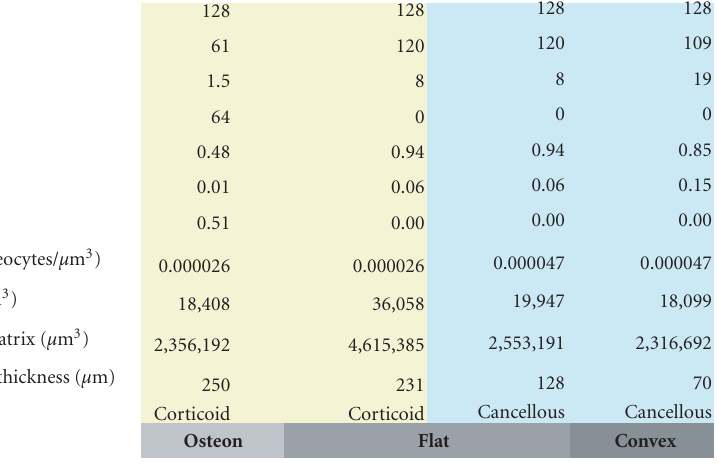
Table 2. Maximum matrix thickness of new bone formation on a concave, flat, or convex surface. This table illustrates the maximum theoretical thickness of new bone formation for the 128 cells illustrated in each geometric configuration shown in Figures 8a, 8b, and 8c. For flat and convex surfaces, the limit occurs when osteoblasts become osteocytes and lining cells and no osteoblast undergoes apoptosis ( ρ A = 0). In contrast, in the concave configuration of an osteon, the thickness is limited by the maximum diameter of a cylinder that can be occupied by a single row of 128 osteoblasts ( ∼ 250 µ m). In this case, approximately half of the initial osteoblasts must still undergo apoptosis if the observed osteocyte density is to be maintained at or near the normal osteocyte density in cortical